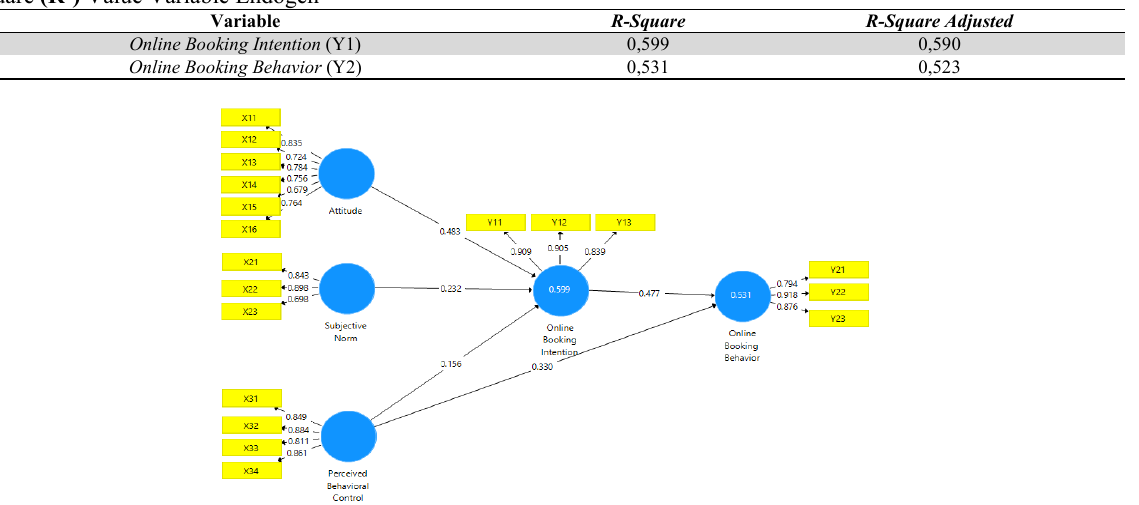
Fig. 2. Algorithm Diagram of SEM-PLS Analysis